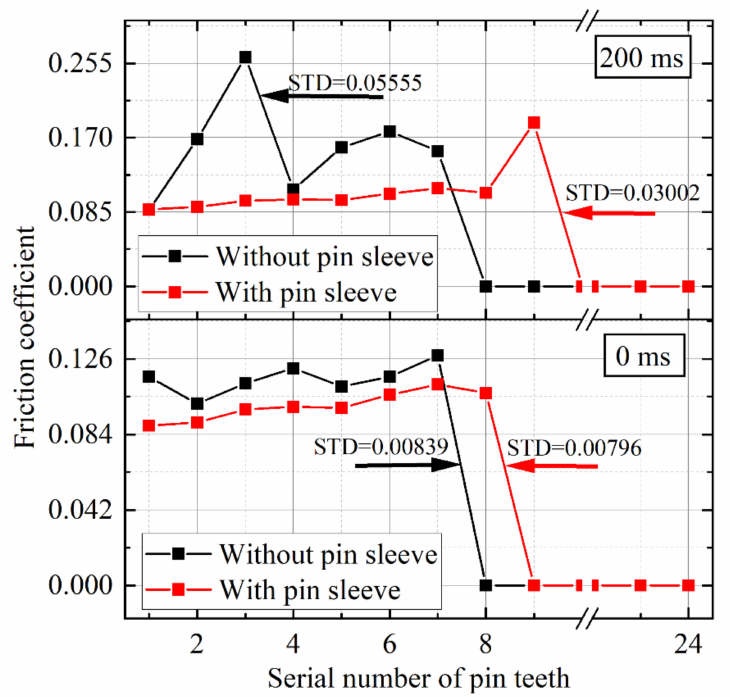
Figure 12. Mixed friction coefficient comparison (w = 20 r/s, Ra = 0.3 µ m). The average power consumption and transmission efficiency for two moments